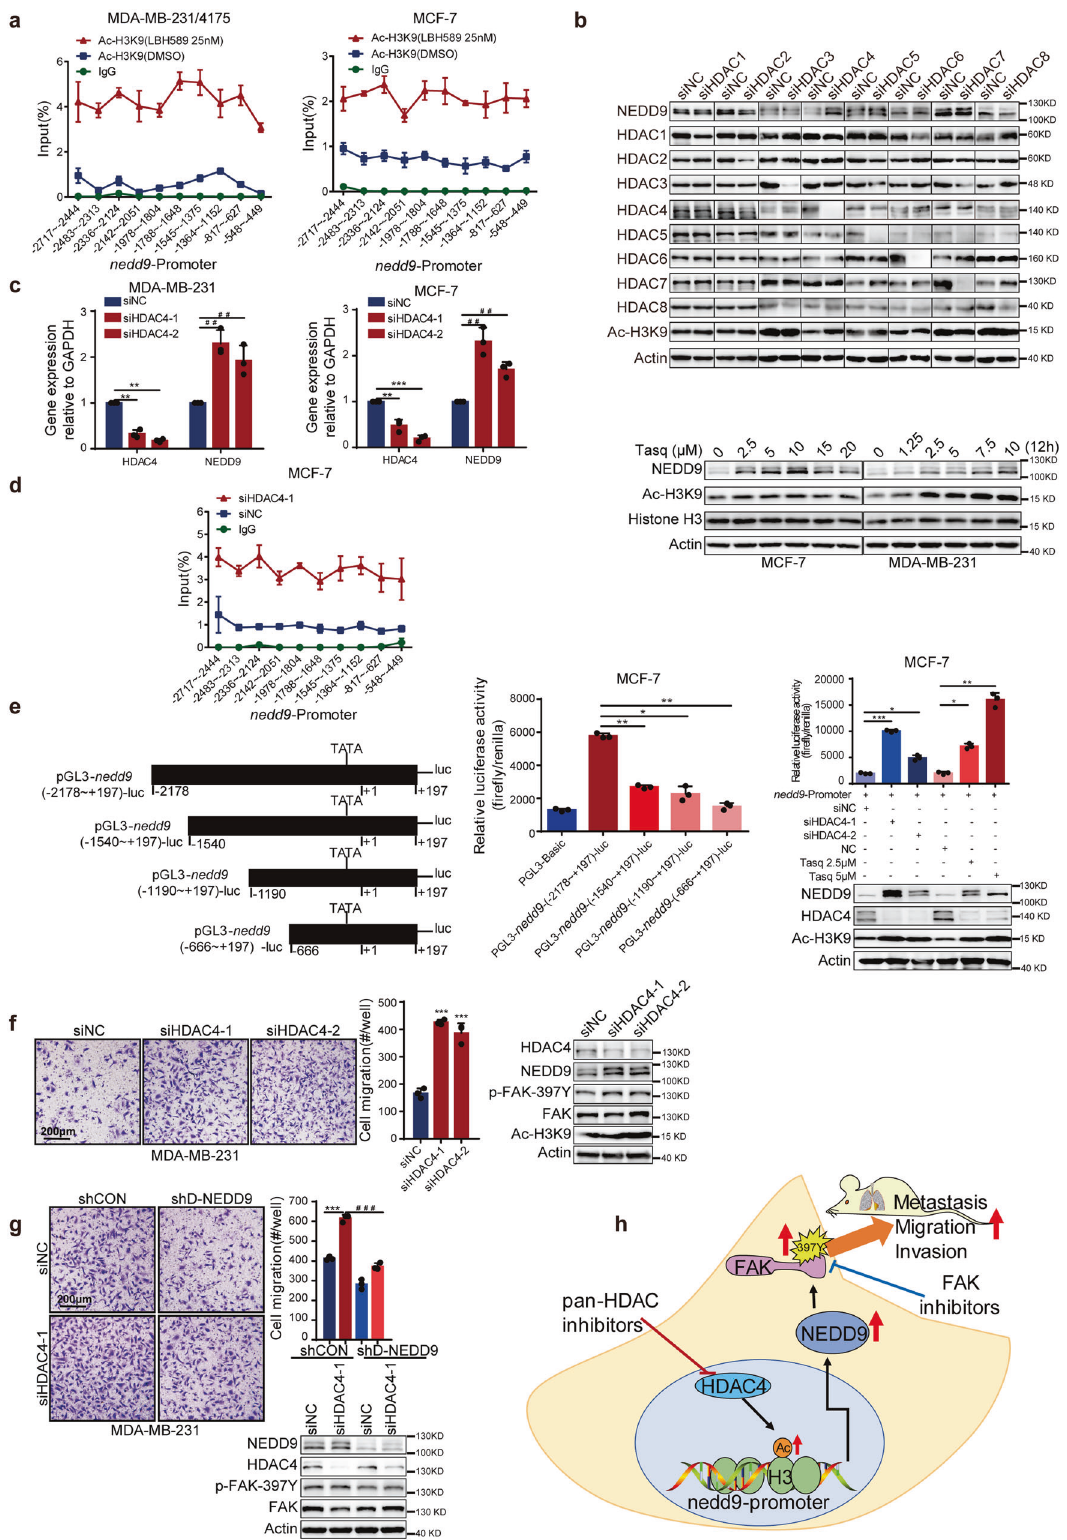
Statistical analysis The statistical difference between indicated groups were analyzed